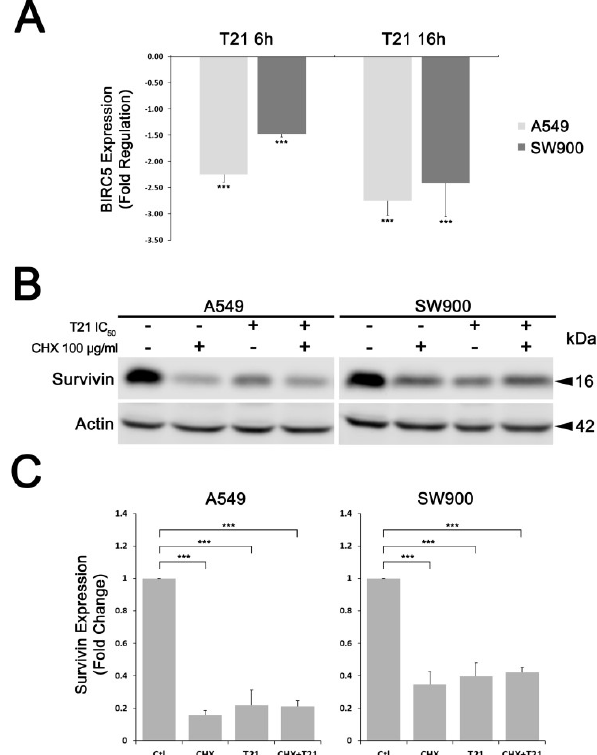
Figure 3. T21 reduces survivin levels through transcriptional repression. ( A ) A549 and SW900 cells were treated with T21 at IC 50 for 6 and 16 h and BIRC5 gene expression was analyzed by RT-qPCR. ( B , C ) survivin levels were assessed by Western blot analysis in A549 and SW900 cells exposed to CHX at 100 µ g / mL for 30 min followed by T21 treatment at IC 50 during 24 h. Results were obtained from at least three independent experiments. Bars represent the mean ± SD. Statistically significant results are indicated as *, p -value < 0.05; **, p -value < 0.01 and ***, p -value < 0.001.